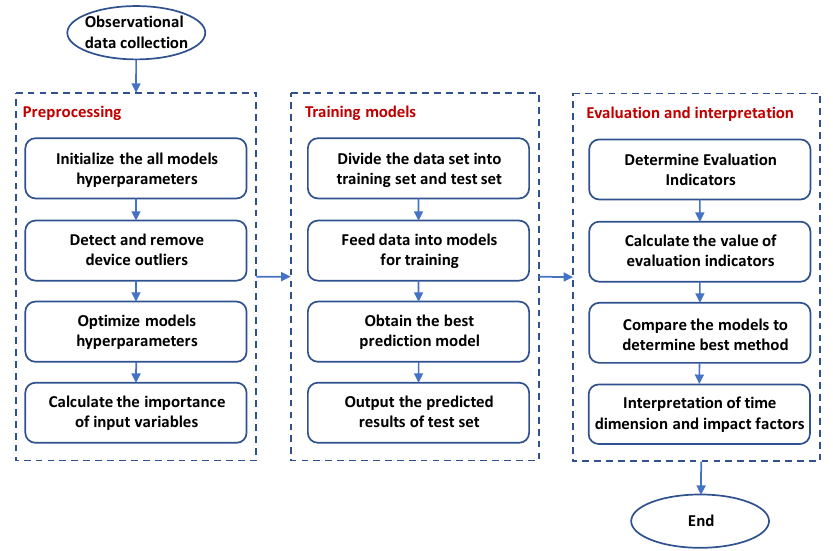
Figure 3. Flowchart of dam deformation prediction based on the coupled algorithm.